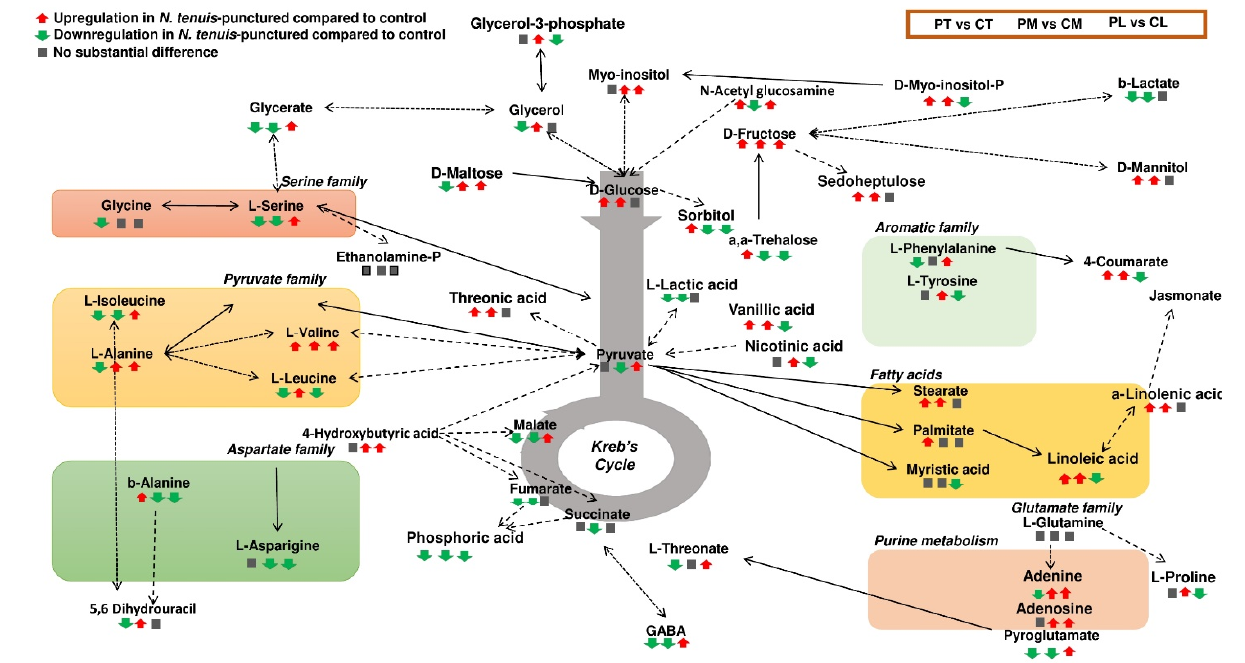
Figure 5. Metabolic network of tomato leaves displaying the differences between the metabolic composition of unpunctured and N. tenuis- punctured leaves. Single-headed or double-headed arrows indicate one or two-way reactions between metabolite pools, respectively. Solid lines symbolize one-step consecutive metabolites in a biosynthetic pathway and dashed lines multi-step or not fully elucidated biosynthetic pathway sections. Three different symbols below each metabolite represent their relative abundance in N. tenuis -punctured tomato plant tissues (top, middle, and lower leaf), as compared to those in the unpunctured plants. Red upward arrow indicates increased abundance in N. tenuis- punctured compared to unpunctured. Green downward arrow indicates decreased abundance in N. tenuis- punctured, compared to unpunctured. Gray squares indicate no substantial differences in the two treatments (PT; predator (punctured)-top, CT; control-top, PM; predator-middle, CM; vs control-middle, PL; predator-lower, CL; control-lower leaves).